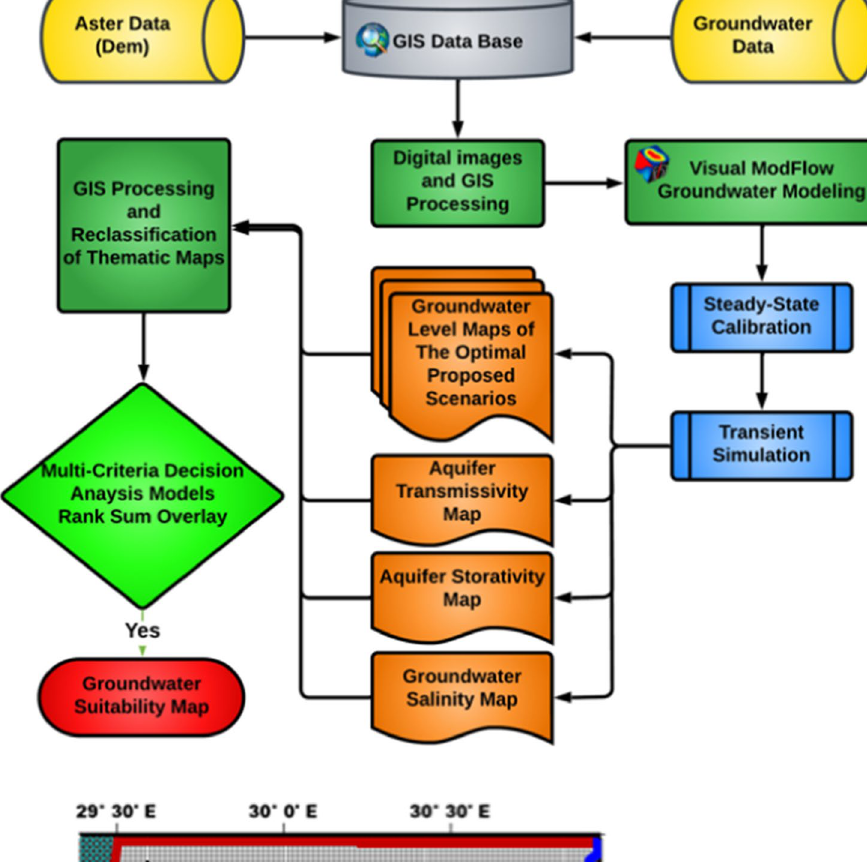
Fig. 9 Numerical grid of the modeled area, hydrologic boundaries, and new develop- ment